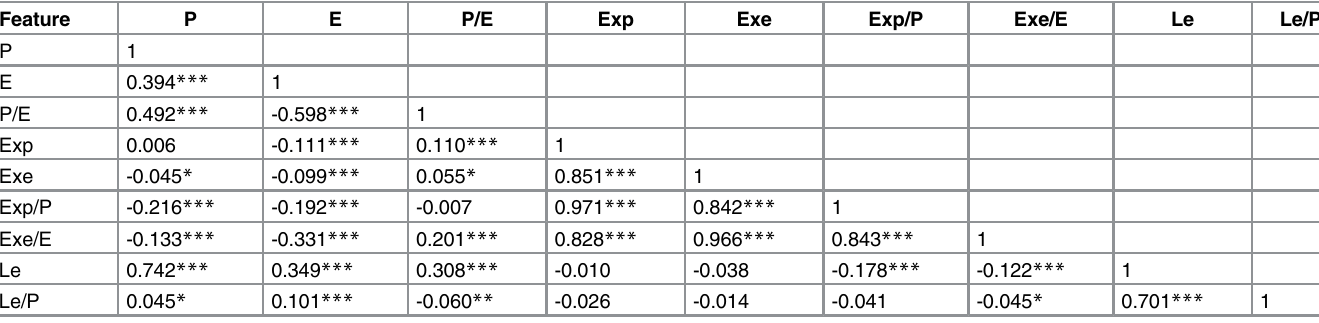
Table 4. The correlation matrix for the observed